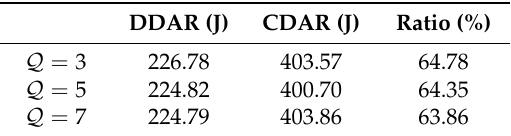
Table 7. Average maximum energy consumption and the ratio in each